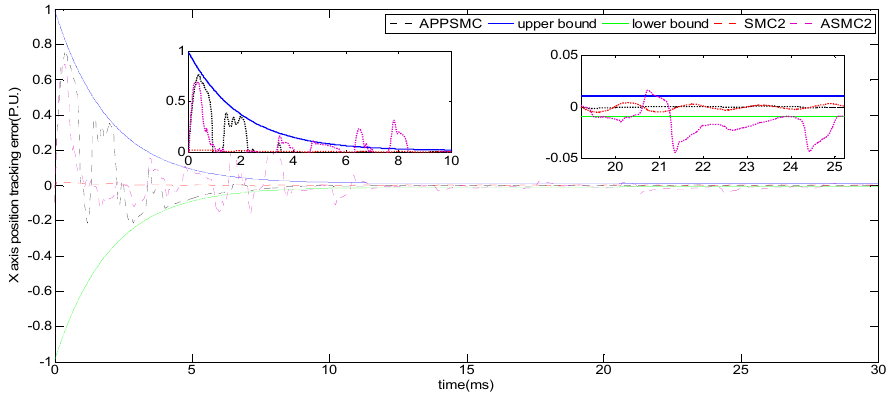
Figure 10. X axis tracking error comparisons of SMC2, ASMC2, and APPSMC.